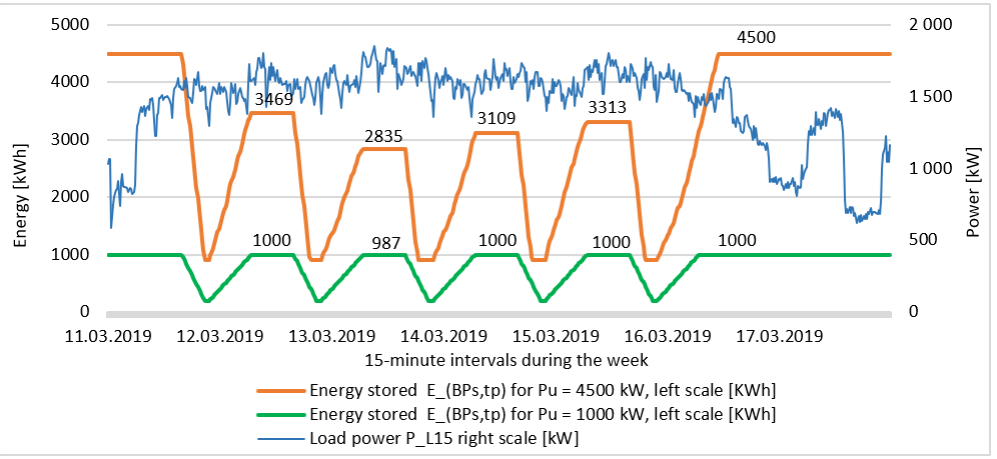
Figure 3. Cumulative state of charge BESS for 1000 kWh capacity and 4500 kWh capacity during the week with the highest load for the A2019 enterprise.